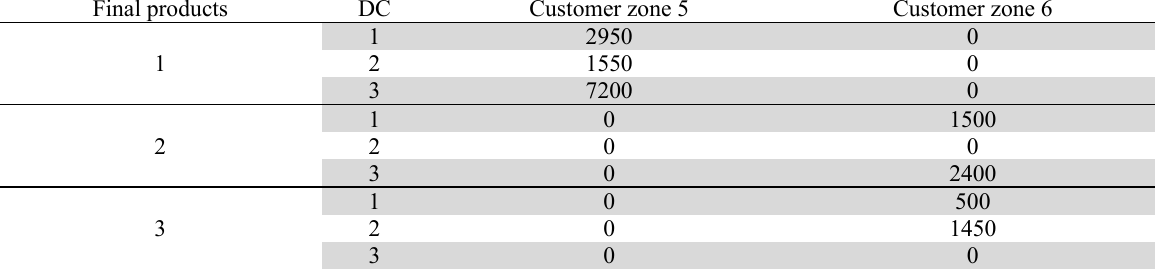
Optimal product flow (tones) from distribution centers (DCs) to customer zones